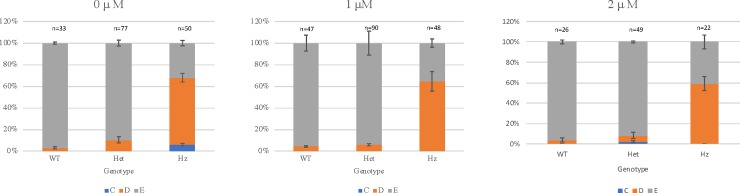
Results of phenotypic and genotypic analysis following treatment of in-crossed heterozygous bmp4st72/+ zebrafish with 0 μM, 1 μM and 2 μM PTC124.Larvae were not dechorionated and PTC124 treatment was started at 0 hours post fertilization (hpf). Analysis was performed at 72 hpf and the results are shown as the mean of 3 independent experiments, except for treatment with 2 μM PTC124, which is shown as the mean of 2 independent experiments. Larvae were scored as wildtype (E), mild reduction/deformity in ventral tail fin (D+ or D) or severe reduction/deformity in ventral tail fin (C). WT = wildtype, het = heterozygote, HZ = homozygote. Error bars show standard error of the mean. We tested for trend in the probability of tail fin defects across the increasing doses of 0 μM, 1.0 μM and 2.0 μM PTC124 treated, groups of homozygous larvae [24]. The probability of tail fin defect decreased from 68% to 64.58% and 59.09% as the dose increased to 1.0 μM and 2.0 μM. However, the trend failed to meet the statistical significance (p = 0.4681).